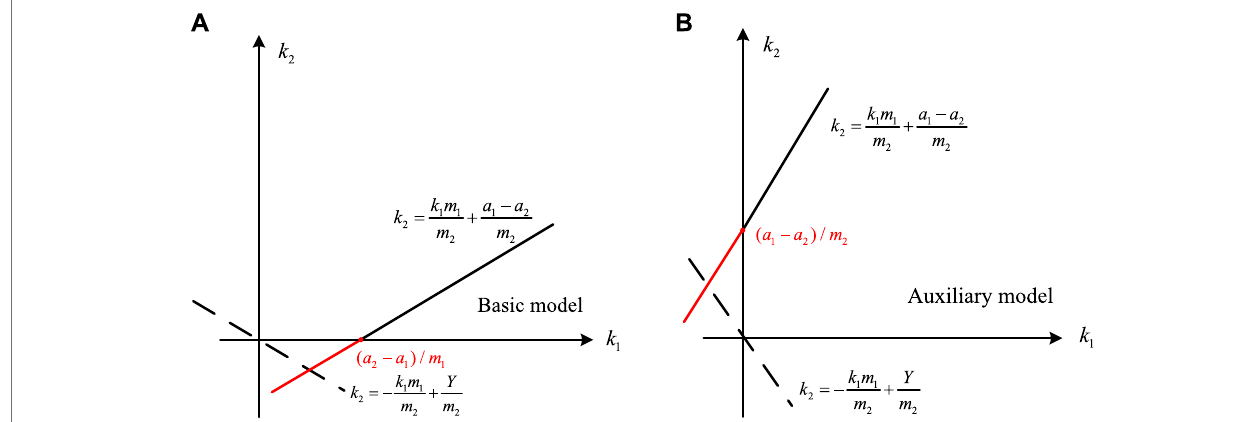
FIGURE 4 | (A) Schematic diagram of objective function and constraint conditions in case of a 2 > a 1 . (B) Schematic diagram of objective function and constraint conditions in case of a 2 < a 1